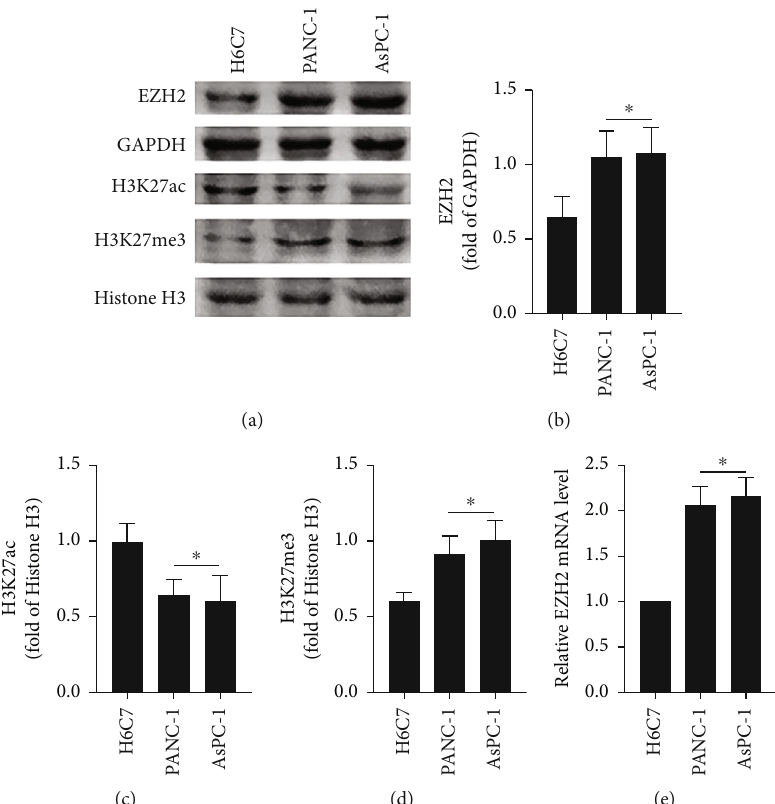
Figure 1: The protein expression levels of EZH2, H3K27ac, and H3K27me3 in cells of PANC-1 and AsPC-1. (a) Representative bands of western blot of EZH2, H3K27ac, H3K27me3, and histone H3 in cells of H6C7, PANC-1, and AsPC-1. (b) The relative band intensity of EZH2 in cells of H6C7, PANC-1, and AsPC-1. (c) The relative band intensity of H3K27ac in cells of H6C7, PANC-1, and AsPC-1. (d) The relative band intensity of H3K27me3 in cells of H6C7, PANC-1, and AsPC-1. (e) The relative mRNA level of EZH2 in cells of H6C7, PANC-1, and AsPC-1. The values were expressed as the means ± S : E : M : ( n = 6 for each group). ∗ P < 0 : 05 vs. the H6C7